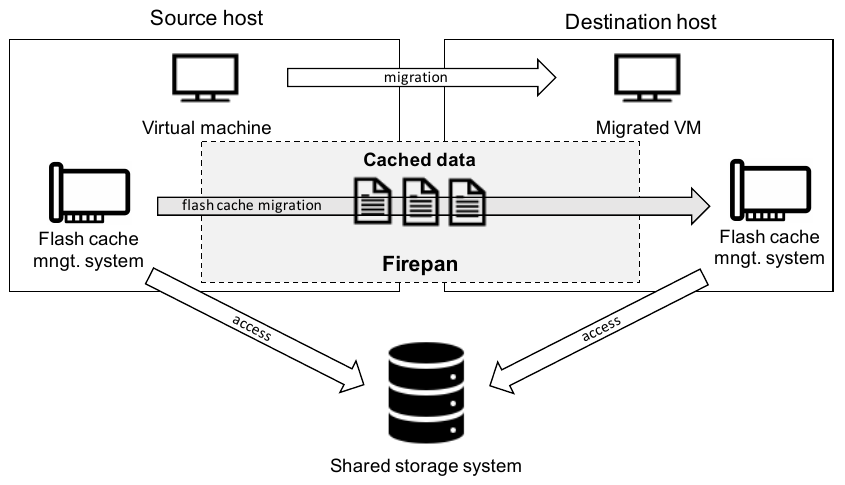
Figure 3. Flash cache migration procedure by